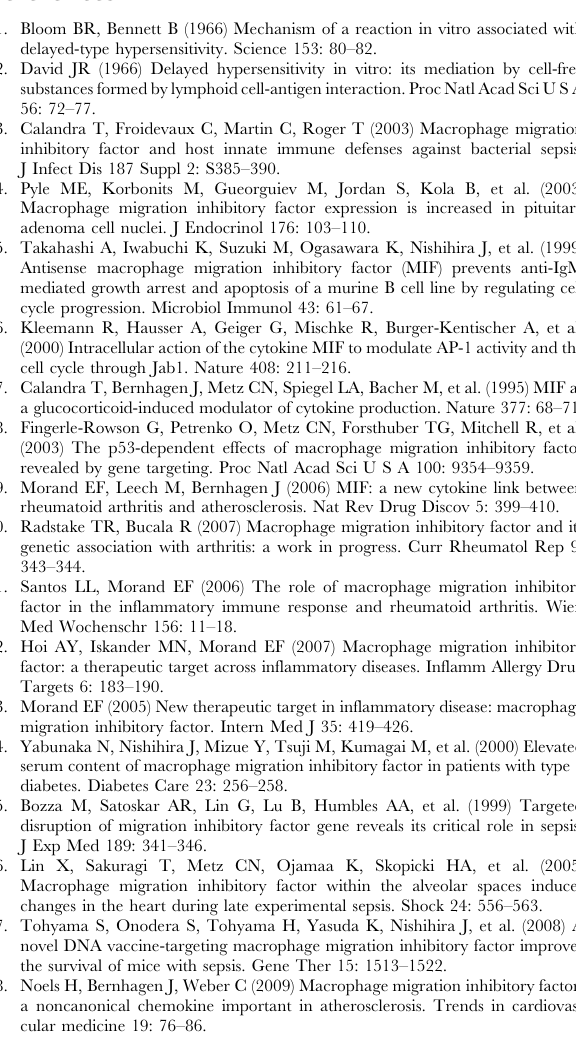
huMIF (B), L46A huMIF (C) and L46G huMIF (d) at 50 m M (solid lines), 15 m M (dashed lines) and 5 m M (dotted lines). (TIFF) Figure S3 NMR chemical shift measurements demon- strate a high similarity between L46A and L46G huMIF, whereas the L46F mutant exhibits a slightly different chemical shift pattern. (A) Two selected regions in 1 H- 15 N HSQC spectra are shown for residues with strong chemical shift deviation. Color codes are as follows: wild-type in black, L46A mutant in red, L46F mutant in green, L46G mutant in blue. (B) Chemical shift differences between L46G MIF and wild-type MIF. (C) Two-dimensional representation of chemical shift deviations of mutant MIF from those of wild-type MIF. The gray square is drawn at + / 2 0.2 ppm in 15 N, + / 2 0.02 ppm in the 1 H dimension and separates very small from larger chemical shift changes. (TIFF) Figure S4 Root mean square fluctuations (RMSF, a measure of the average atomic mobility) of the C a atoms during the molecular dynamics simulations of wt and Leu46 mutants. Black line, wt huMIF; blue line, L46F huMIF; red line, L46A huMIF; green line, L46G huMIF. (TIFF)